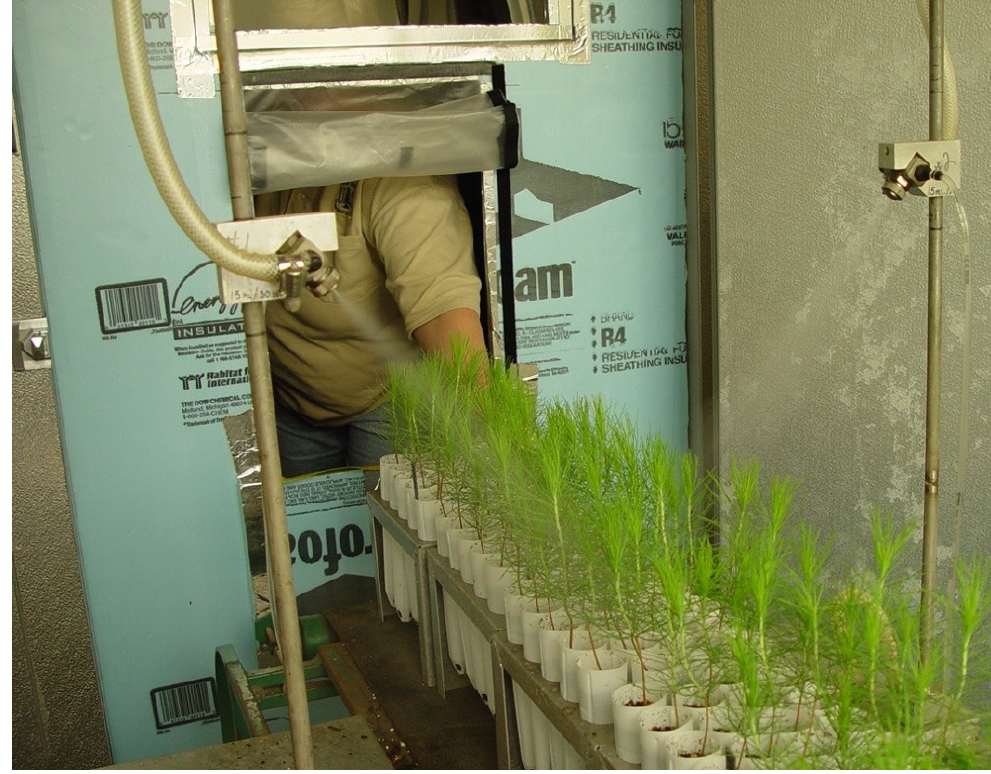
Figure 1. Concentrated Basidiospore Spray (CBS) inoculation system used at the Resistance Screening Center. As trays of seedlings in their individual plastic tubes move along a conveyor belt, seedlings are sprayed with the concentrated basidiospore suspension. After inoculation, the trays of seedlings are immediately placed in the controlled temperature and high humidity incubation chamber. After 24 h in the chamber they are removed to a holding area where they are allowed to equilibrate with normal room conditions for an additional 24 h. Seedlings are then transferred to greenhouses were they remain for 6 months until inspection for fusiform rust symptoms and reports to clients who submitted their seed lots for evaluation for resistance to fusiform